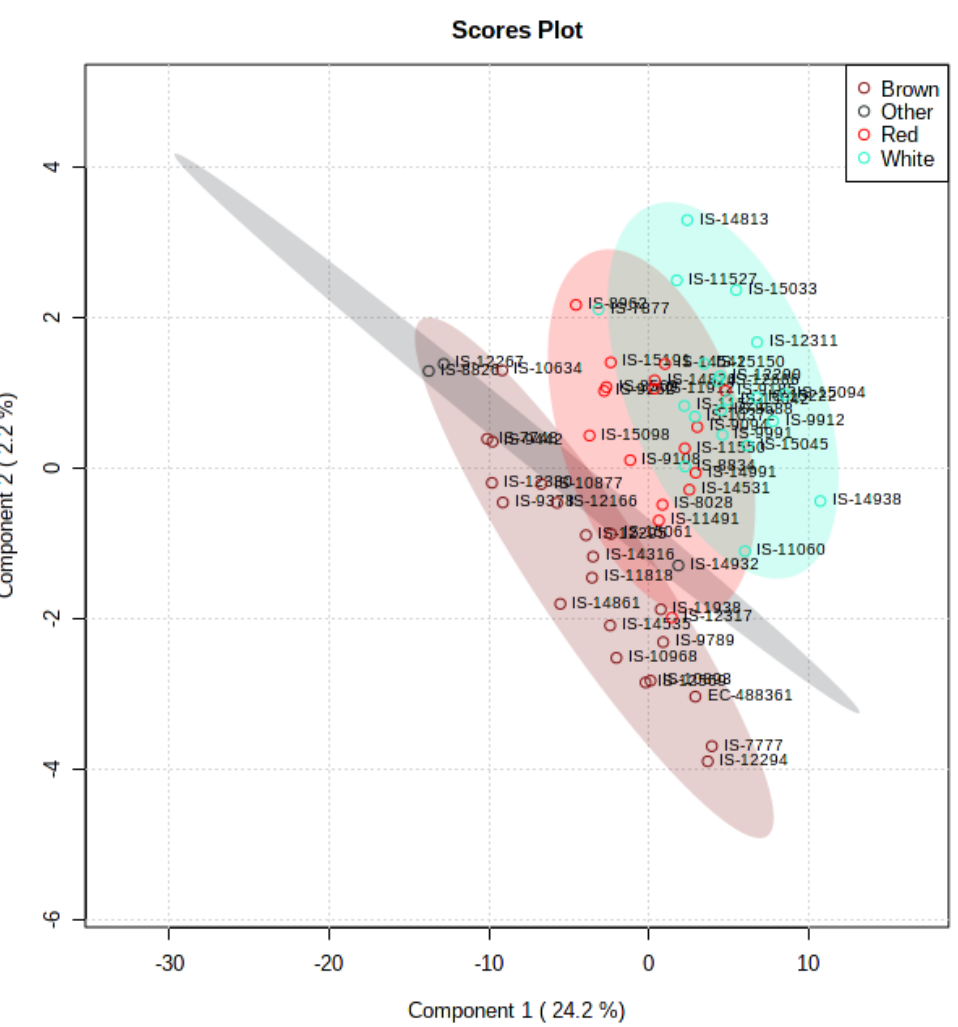
Figure 8. Score plots of partial least square-discriminant analysis (PLS-DA) using the data generated through non-targeted metabolomics analysis of diverse sorghum genotypes differing in grain color.